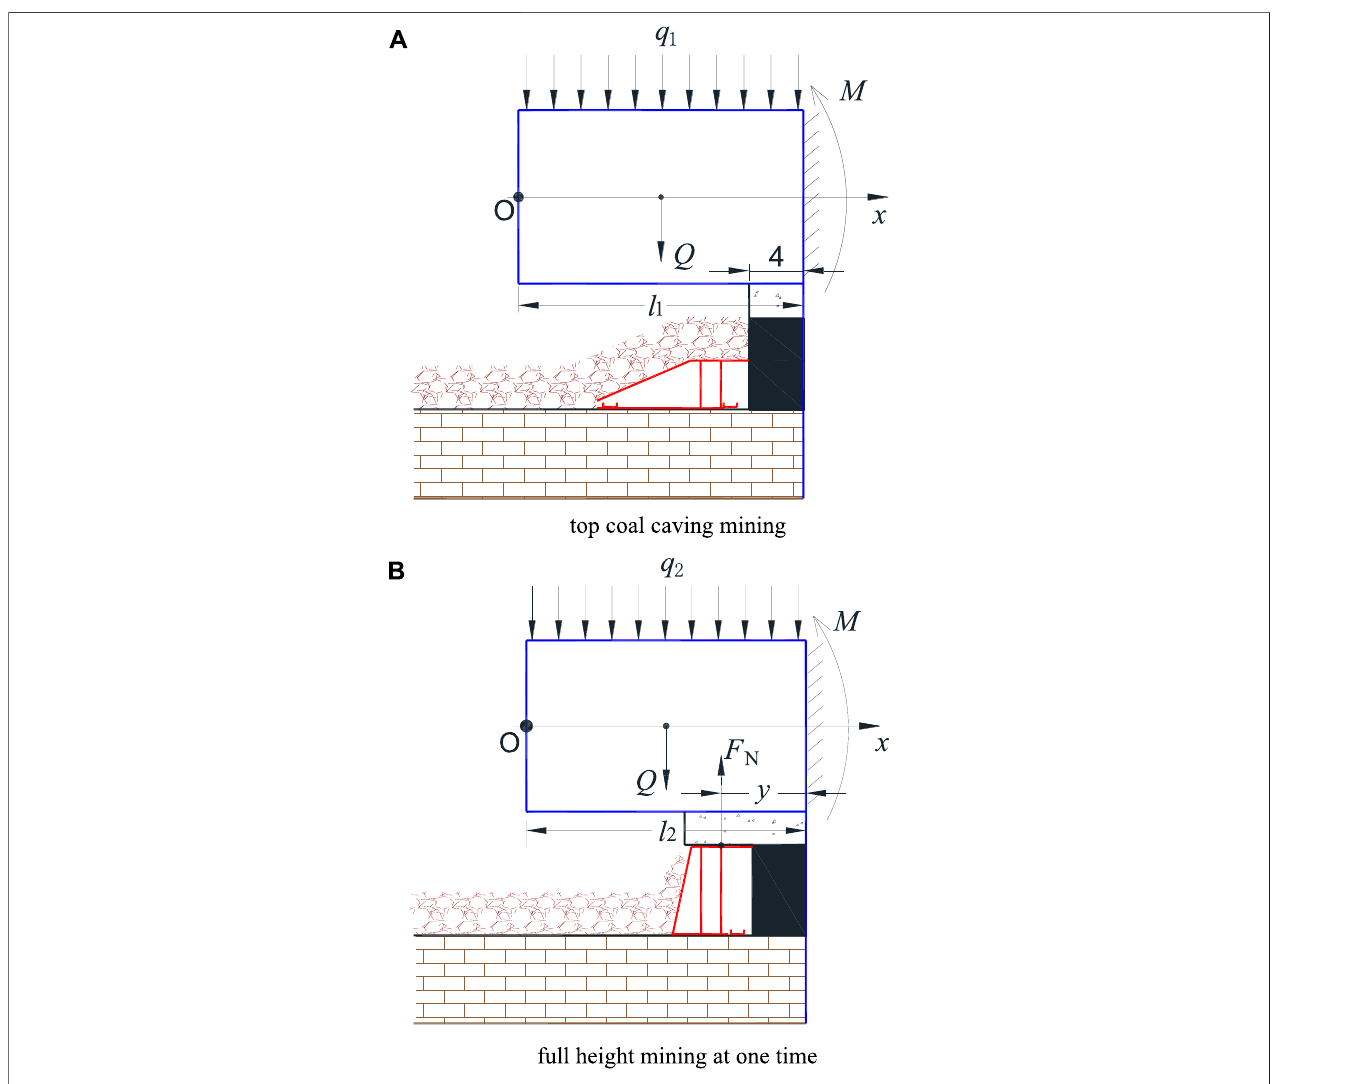
FIGURE 3 | Schematic diagram of stress on basic top rock beam. (A) top coal caving mining. (B) full height mining at one time.